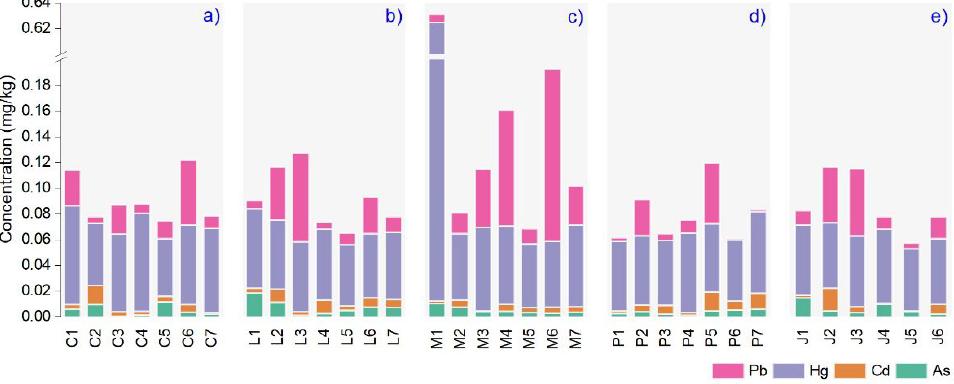
Figure 1. The toxic elemental content (mg/kg) quantified in each essential oil: ( a ) Thymus vulgaris L., ( b ) Lavandula augustifolia Mill., ( c ) Mentha × pipperita L., ( d ) Pinus sylvestris L., ( e ) Juniperus communis L.